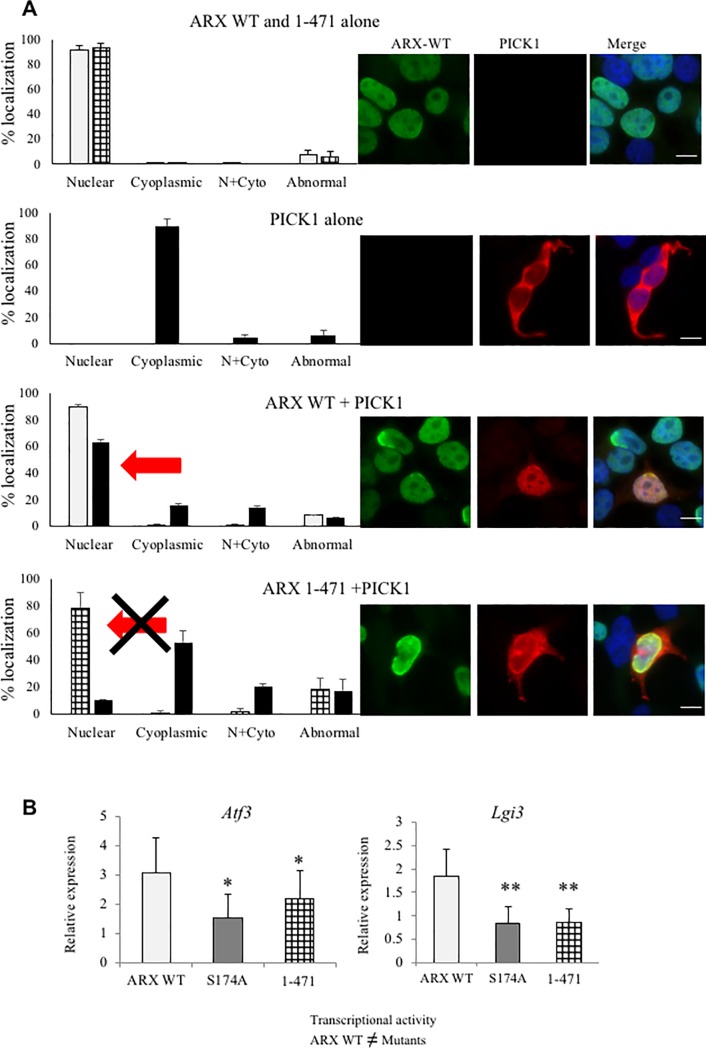
C-terminal region of ARX is required to bind and co-localise PICK1 and aspects of transcriptional activity.A) Left hand panel shows graphs depicting the percentage of transfected cells with nuclear, cytoplasmic, both nuclear and cytoplasmic or abnormal subcellular localisation for ARX-WT (grey), ARX 1–471 (cross hatched), PICK1 (black) and when co-transfected. The percentage of cells was determined from ARX-WT alone (n = 850); PICK1 alone (n = 252), ARX 1–471 alone (n = 514), and co-transfected with ARX-WT and PICK1 (n = 260) and ARX 1–471 and PICK1 (n = 228) from at least two separate transfection reactions, 24 hours post transfection. The right-hand panel shows pictomicrographs of the predominant subcellular localisation for each construct, with ARX proteins detected in green (Alexa-488) and PICK1 detected in red (Alexa-555), with the merged image on far right. Scale bar = 10μm. B) qRT-PCR analysis of changes to deregulated gene expression with ARX WT, S174A phospho-null mutant and the C-terminal truncated ARX 1–471 overexpressed in alpha TC. cDNA was prepared from total RNA extracted from transfected alpha-TC. Expression values measured by qRT-PCR were normalised to reference gene Beta-Actin. Individual graphs for each gene are shown relative to expression in mock transfected alpha-TC cells set at 1.0, with ARX WT (pale grey), S174A phospho-null mutant (dark grey) and C-terminal truncated 1–471 (cross hatched). Error bars indicate standard error of the mean from replicate cDNA samples prepared from repeat transfections. *P<0.05, **P<0.01 (one-tailed t-test of S174A or 1–471 mutant compared to ARX WT).